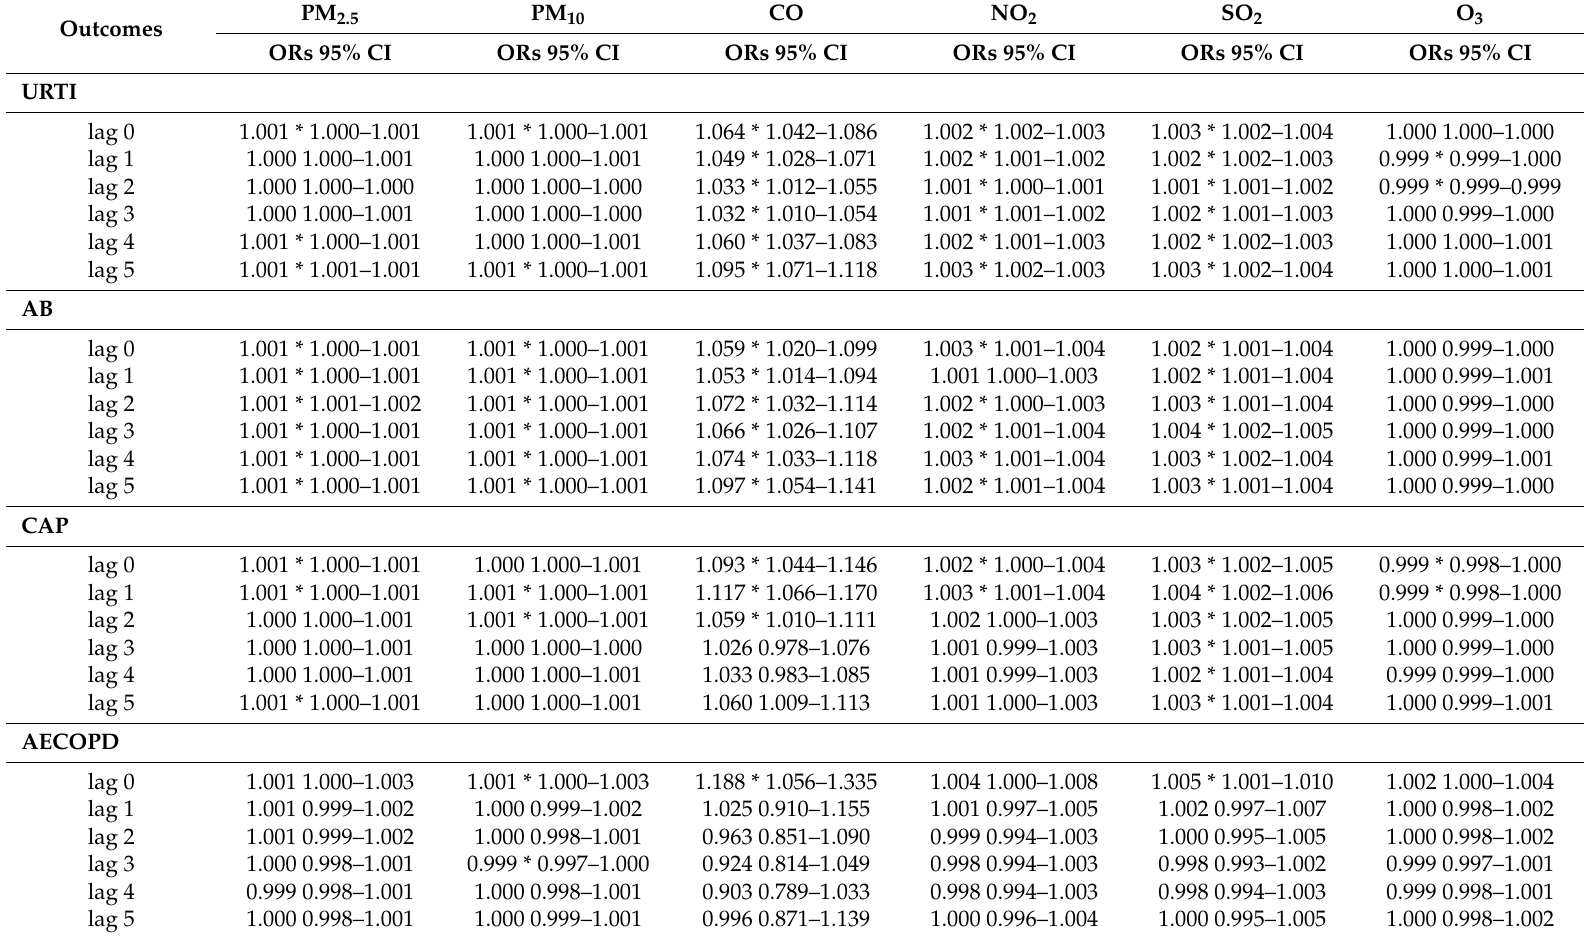
Table 3. Associations between air pollutants and outpatient visits for acute respiratory